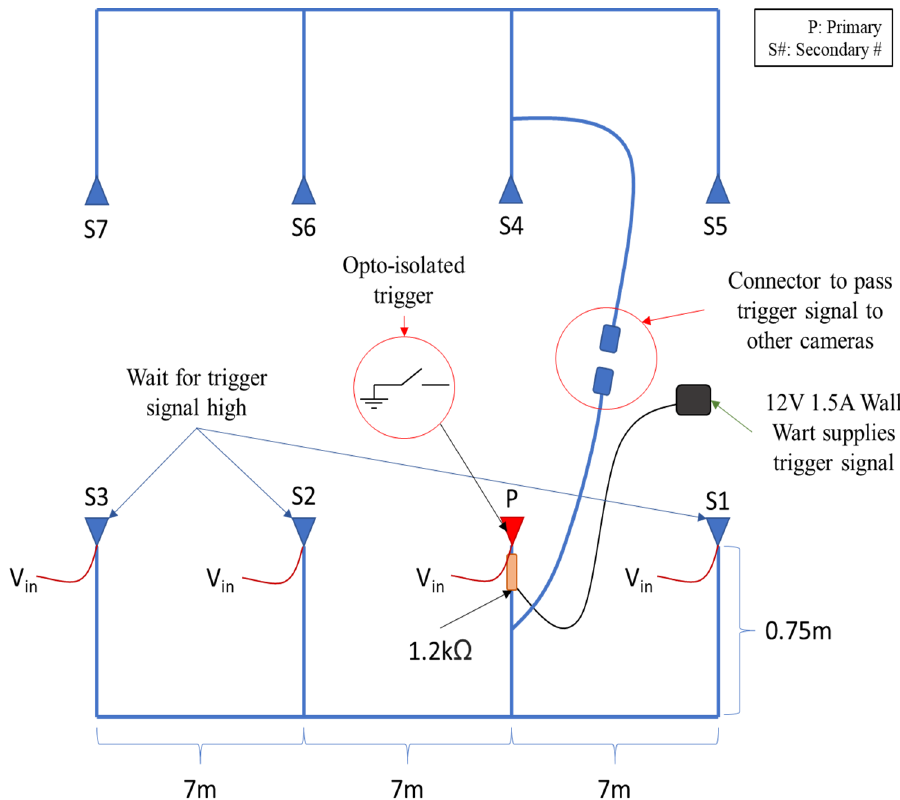
Figure A5. Multi-camera synchronization cable expanded to an eight-camera setup.